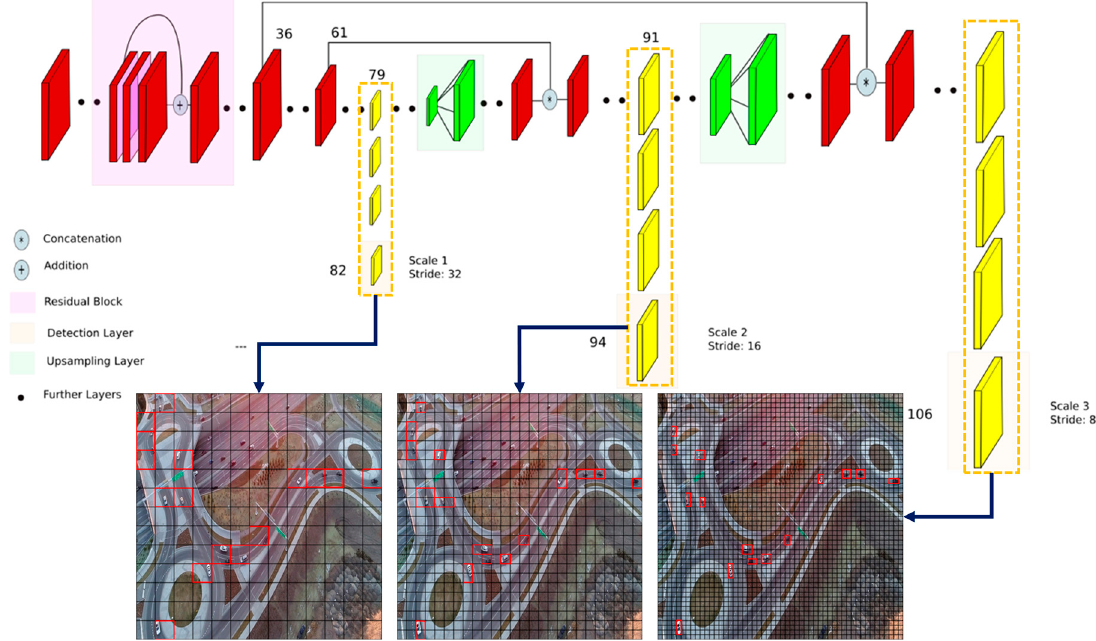
Figure 2. The You Only Look Once (YOLOv3) network architecture, modified from [25].